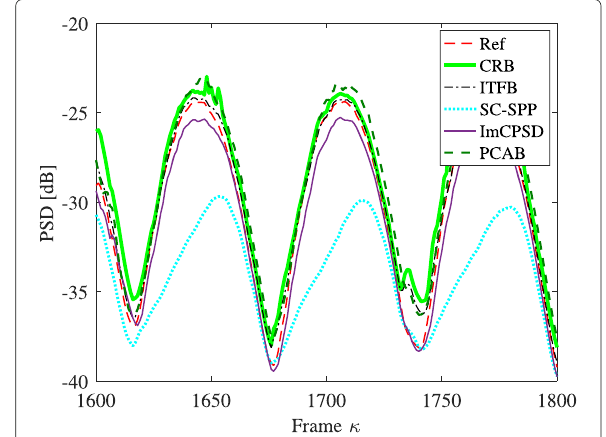
Fig. 6 Comparison of estimated noise PSD as a factor of time at the leftear by different algorithms. Here, f m = 1 Hz and SNR = − 5 dB, θ = − 90 ◦ , averaged over all frequencies